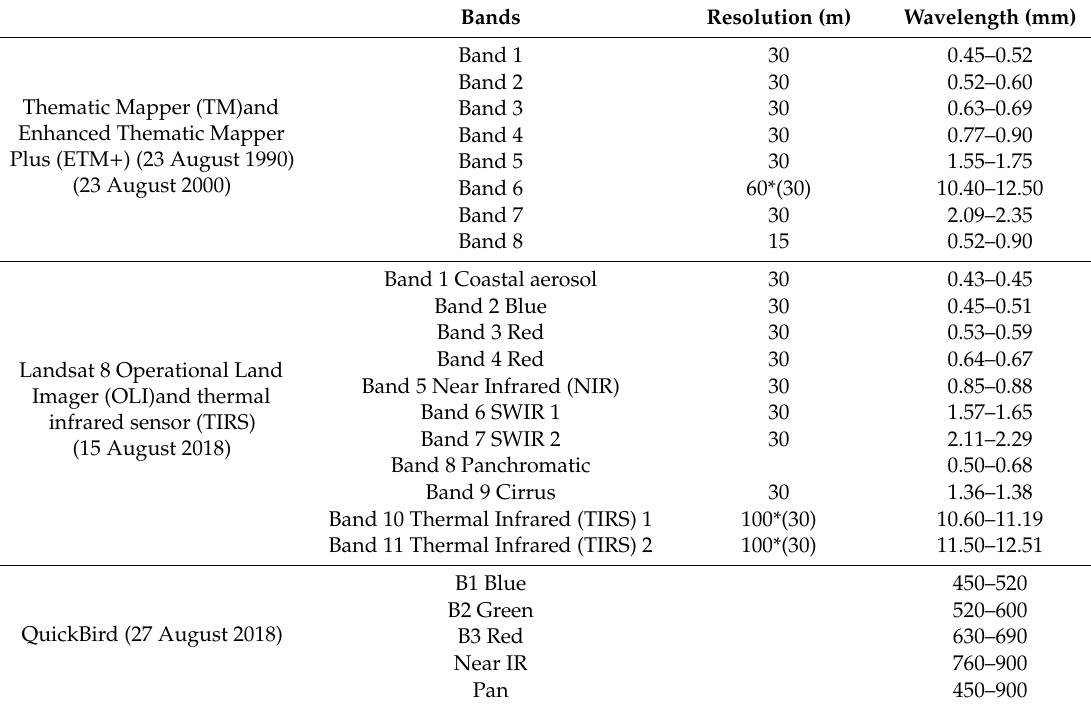
Table 1. Characteristics of Landsat and QuickBird images used in the study